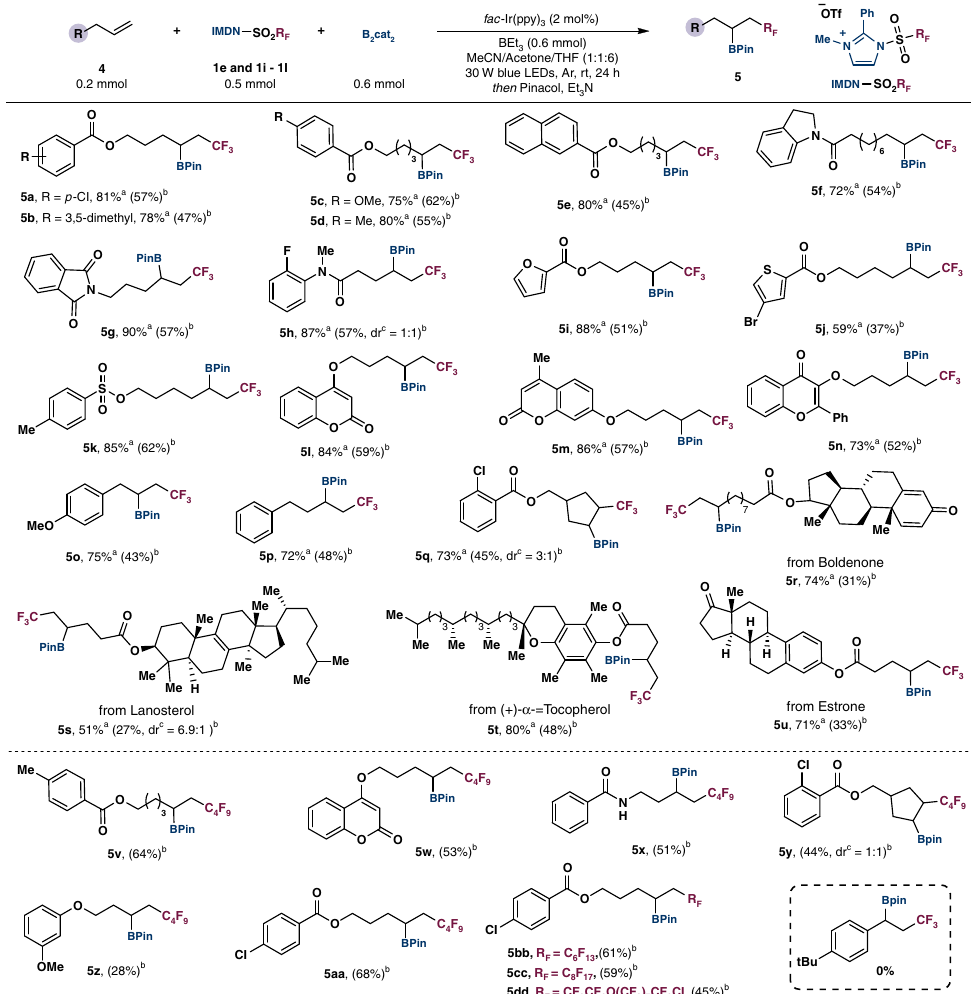
Fig. 3 Substrate scope of the ole fi ns. a Crude yields determined by 19 F NMR. b Values in parentheses are isolated yields. c The diastereomeric ratio determined by 1 H